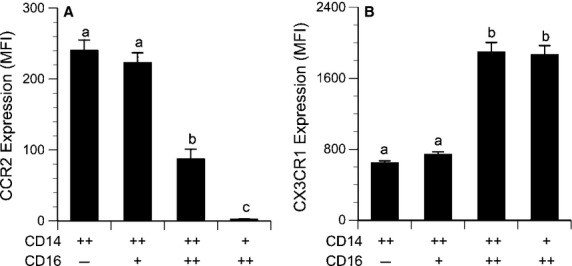
Receptor expression on circulating monocyte subpopulations expressed as mean fluorescence intensity minus fluorescence of the isotype control (n = 34). (A) CCR2: a > b > c, all pairwise comparisons P < 0.0001. (B) CX3CR1: a < b, P < 0.0001.